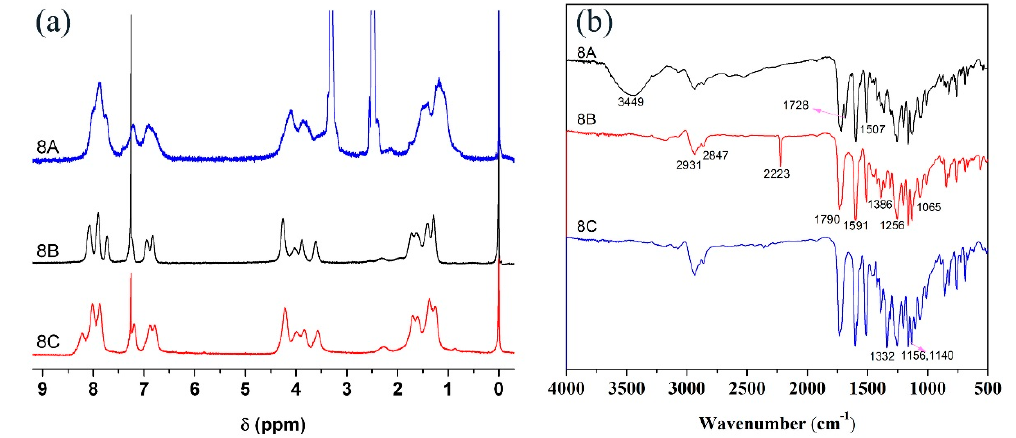
Figure 3. Proton NMR spectra ( a ) and FTIR spectra ( b ) of 8A , 8B , and 8C .